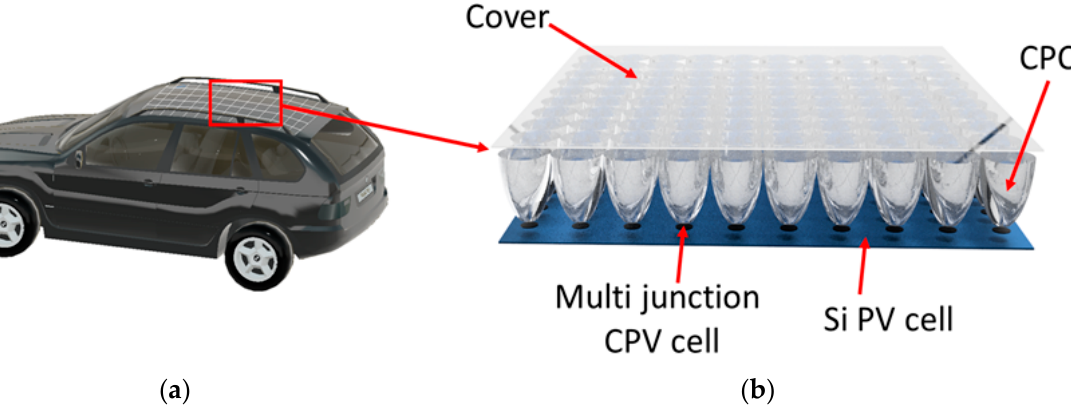
Figure 1. The proposed static CPV module for an automotive application. ( a ) CPV module is in- stalled on the car roof. ( b ) The detailed structure of the static CPV module. on the car roof. ( b ) The detailed structure of the static CPV